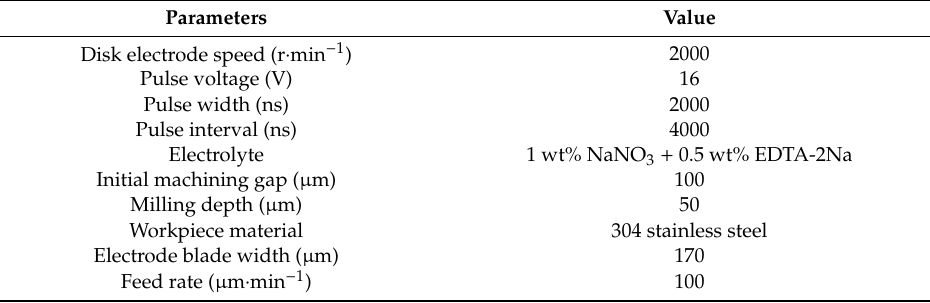
Table 2. Micro-electrochemical milling parameters of the single-edge disk electrode.